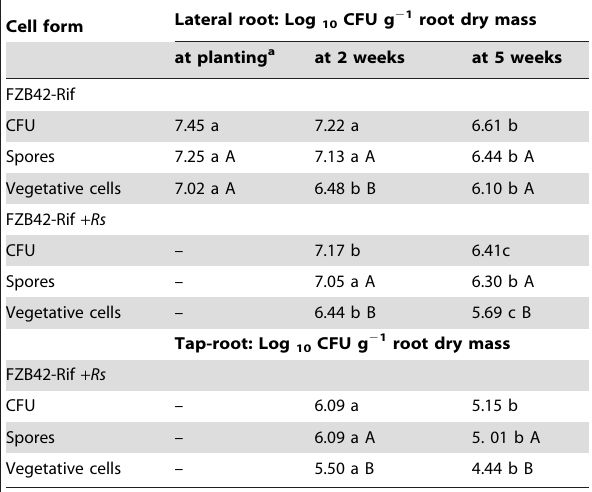
Table 3. Root colonization by Bacillus amyloliquefaciens FZB42-Rif in the